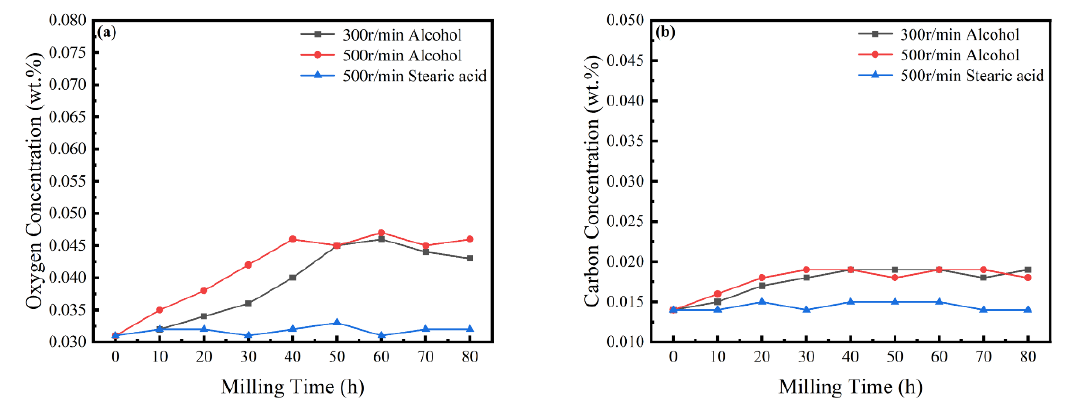
Figure 9. Powder O and C concentrations at different milling times. ( a ) O concentrations; and ( b ) C concentrations.